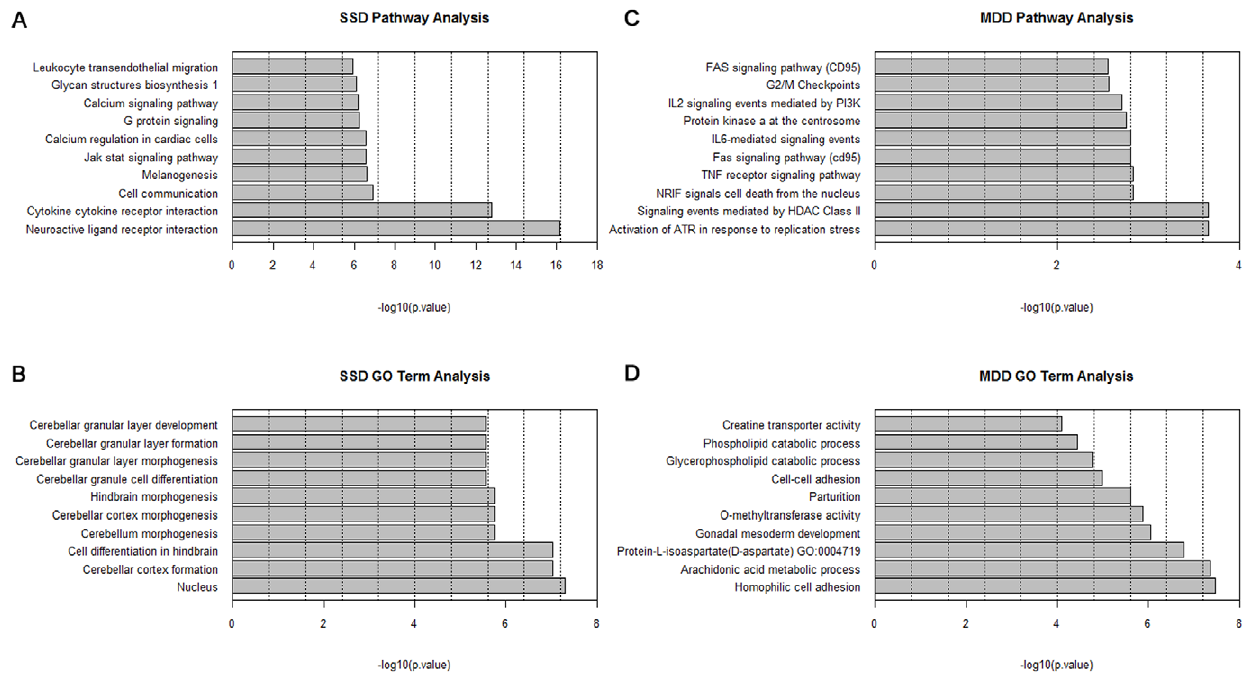
Figure 1. Functional annotation of the DEGs in SSD and MDD. (A) and (C) Pathway analysis of SSD-associated and MDD-associated genes respectively. The y-axis shows the KEGG Pathway terms, and the x-axis shows the enrichment significance P-values for the top 10 enriched Pathway terms. (B) and (D) GO analysis of SSD-associated and MDD-associated genes respectively. The y-axis shows the GO terms, and the x-axis shows the enrichment significance P-values for the top 10 enriched GO terms. Term GO:0004719 remarks the function of protein-L-isoaspartate (D-aspartate) O- methyltransferase activity. MDD: Major depression disorder; SSD: Subsyndromal symptomatic depression.